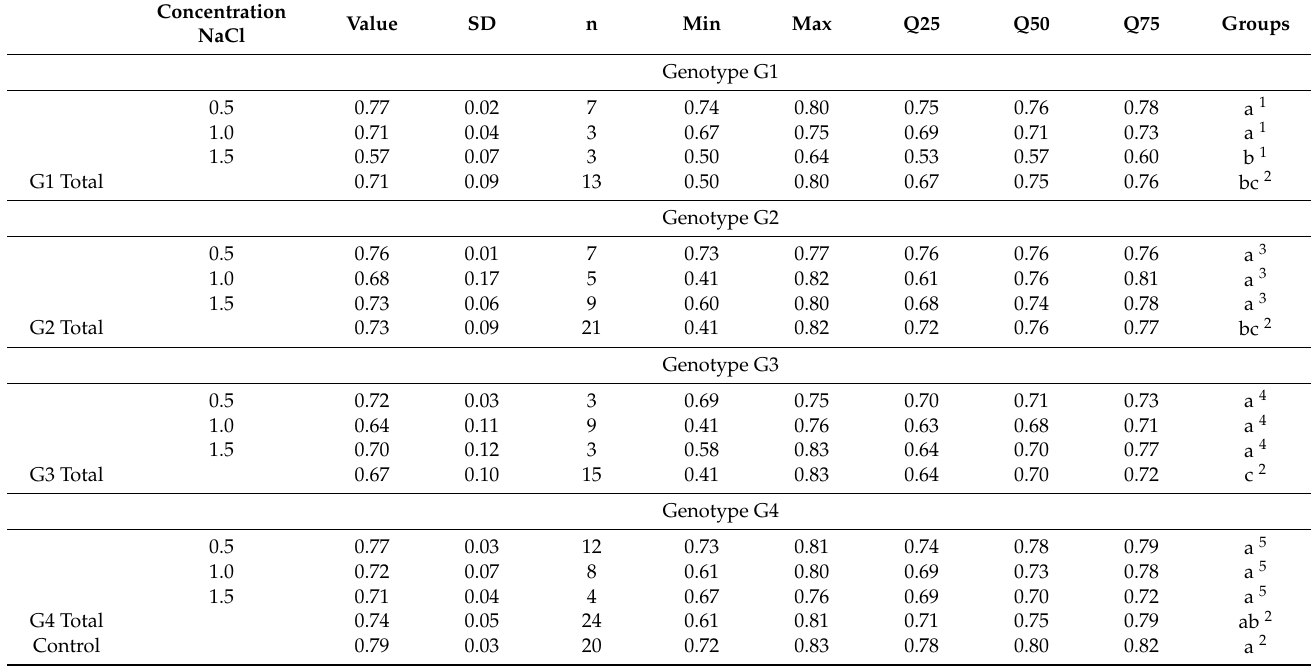
Table 6. Results and statistics of maximum quantum efficiency of photosystem II (Fv/Fm) values for the genotypes: G1–G4 under the influence of salinity, concentration of NaCl: 0.5, 1.0, 1.5 (%),